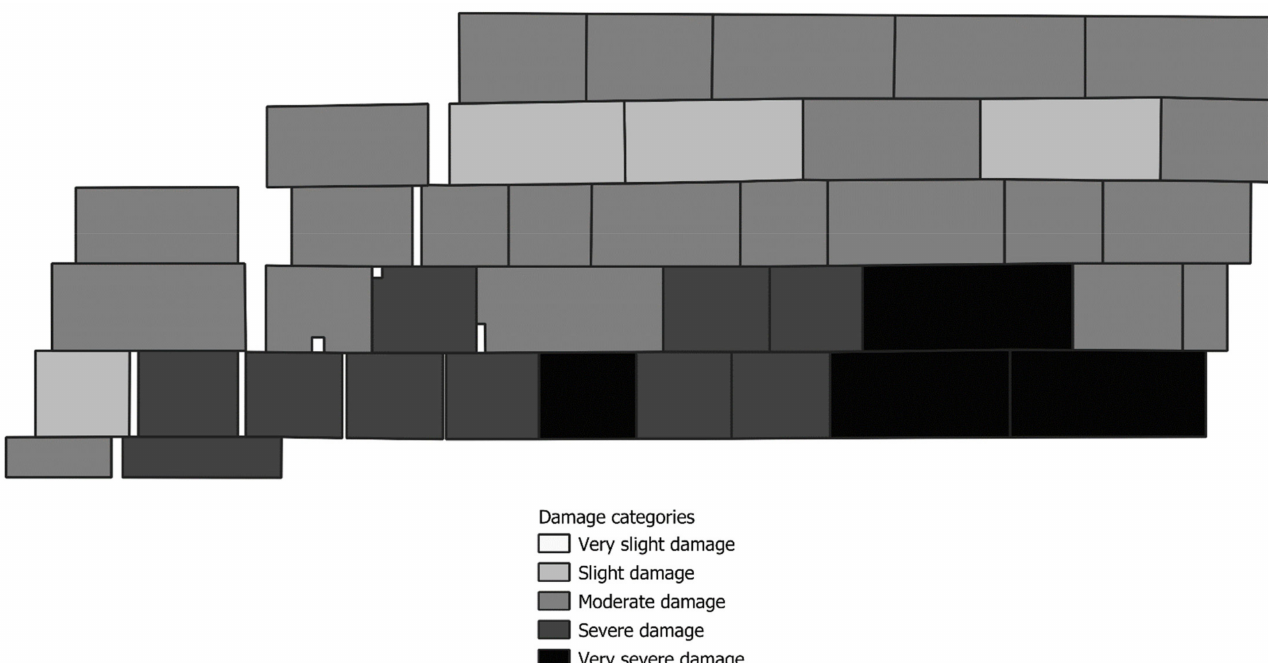
Figure 22. Damage index map, of an ancient wall at the archaeological site of